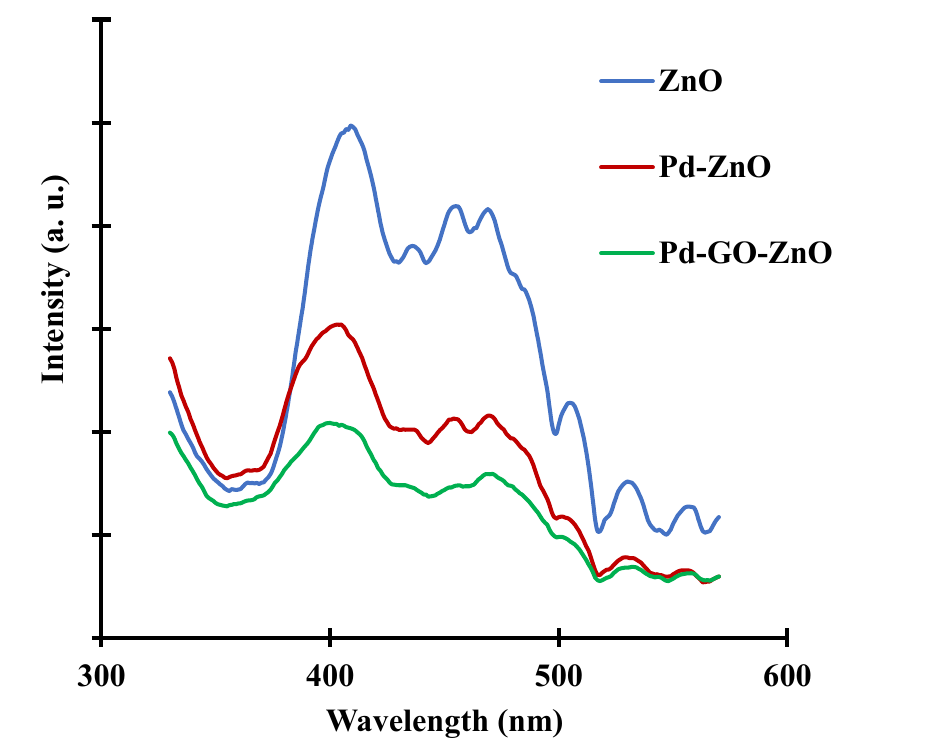
Figure 6. Photoluminescence spectra of the photocatalysts. The XPS survey spectra of the different synthesized photocatalysts demonstrated the occurrence of O, Zn, C and Pd. In the case of bare ZnO and Pd-ZnO, the detected carbon was attributed to the adventitious carbon contamination usually occurring in the analysis of several samples by XPS. Figure 7 shows the high resolution XPS spectra of the ZnO, Pd-ZnO, and Pd-GO-ZnO-5 materials. Since the XPS spectra of the Pd-GO-ZnO samples, containing different amounts of palladium and GO, are quite similar in their characteristics, representative XPS data are reported herein only for the Pd-GO-ZnO-5 together with the data belonging to bare ZnO and Pd-ZnO. The Zn 2p 3/2 XP core level of the three samples is depicted in Figure 7A. As seen, both samples exhibited symmetric Zn 2p 3/2 peaks centered at 1022.63, 1022.85 and 1022.95 eV for the bare ZnO, Pd-ZnO and Pd-GO-ZnO-5 samples, respectively. The registered slight shifts towards higher binding energies denote clearly that the chemical environment of the Zn surface atoms was modified upon incorporation of palladium and graphene oxide on the ZnO material. Furthermore, as depicted in Figure 7B for the O1s region, the bare ZnO sample exhibited a peak deconvoluted into two contributing peaks centered at 530.85 and 532.72 eV. These peaks were assigned to the O 2 − ions in the wurtzite structure surrounded by the Zn atoms and to the specific chemisorbed oxygen, adsorbed O 2 , or adsorbed H 2 O, respectively [38,39]. Moreover, an additional peak centered at ca. 534.4 eV was observed in the O1s region of the Pd-ZnO and Pd-GO-ZnO samples (Figure 7B), corresponding probably to the formation of metal-oxide such as Pd-O-Zn [40]. As for the Pd3d 5/2 high resolution spectra presented in Figure 7C, they could be deconvoluted into two contributing peaks centered at 335.35 and 337.49 eV and attributed to metallic palladium Pd(0) and oxidized Pd(II), respectively